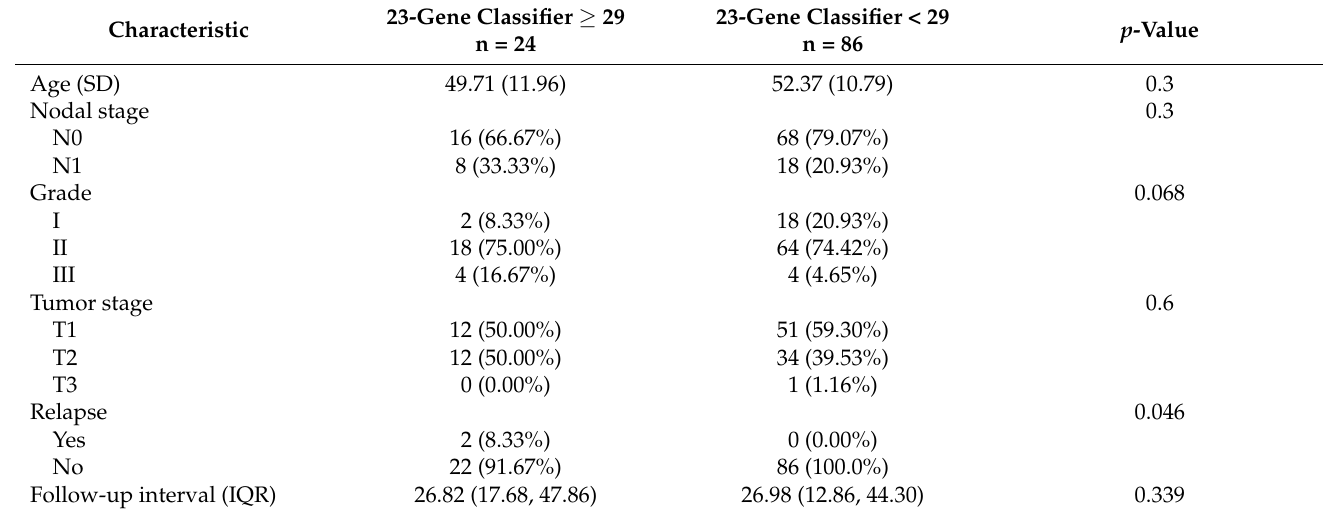
Table 2. Patient characteristics according to the 23-gene classifier.